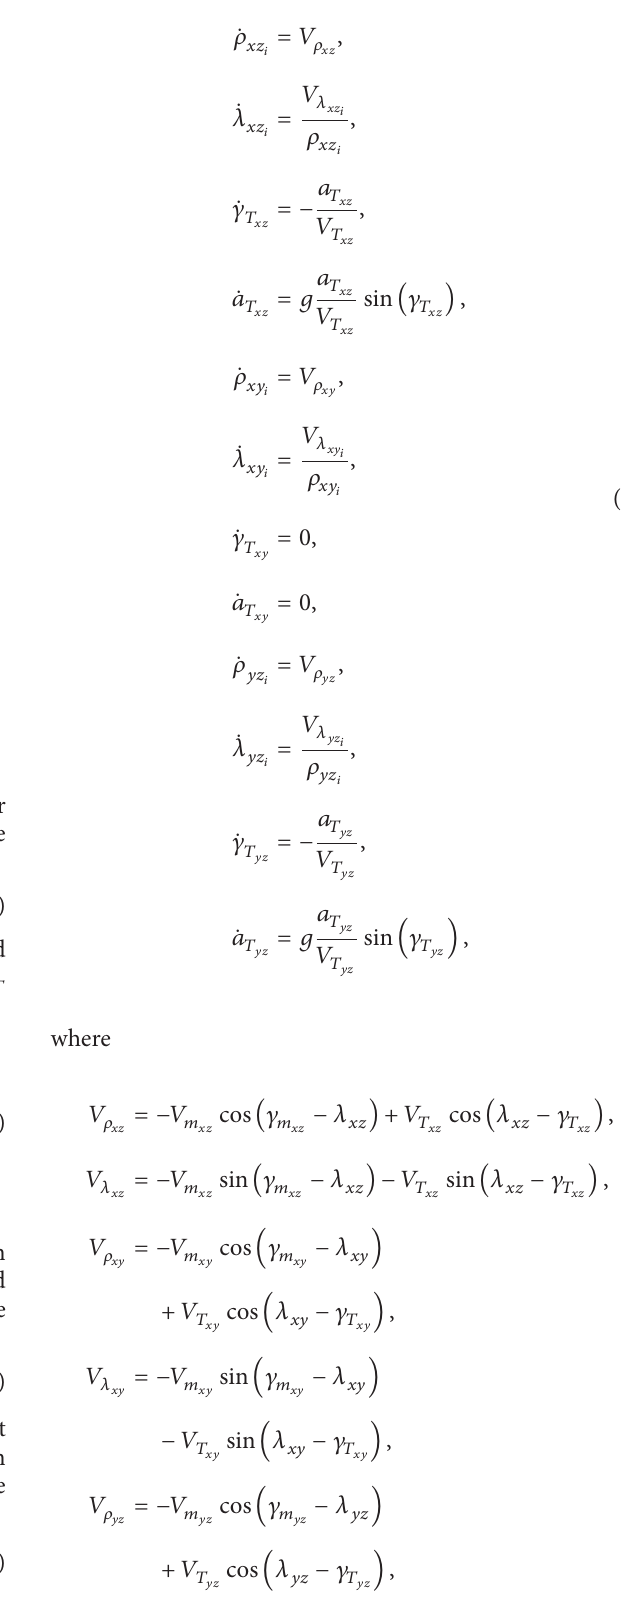
Figure 2: Radar geometry.